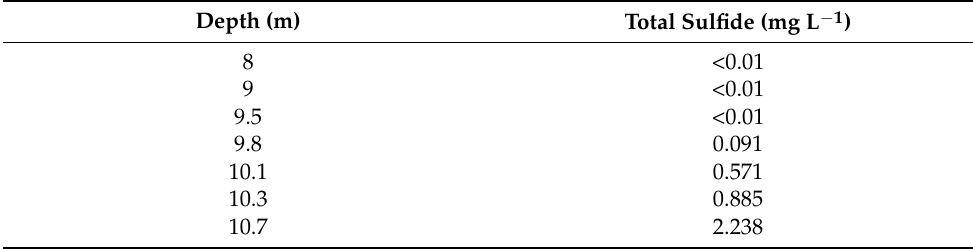
Table 1. Total sulfide measurements on Lake Fryxell water samples collected on 17 January 2020.